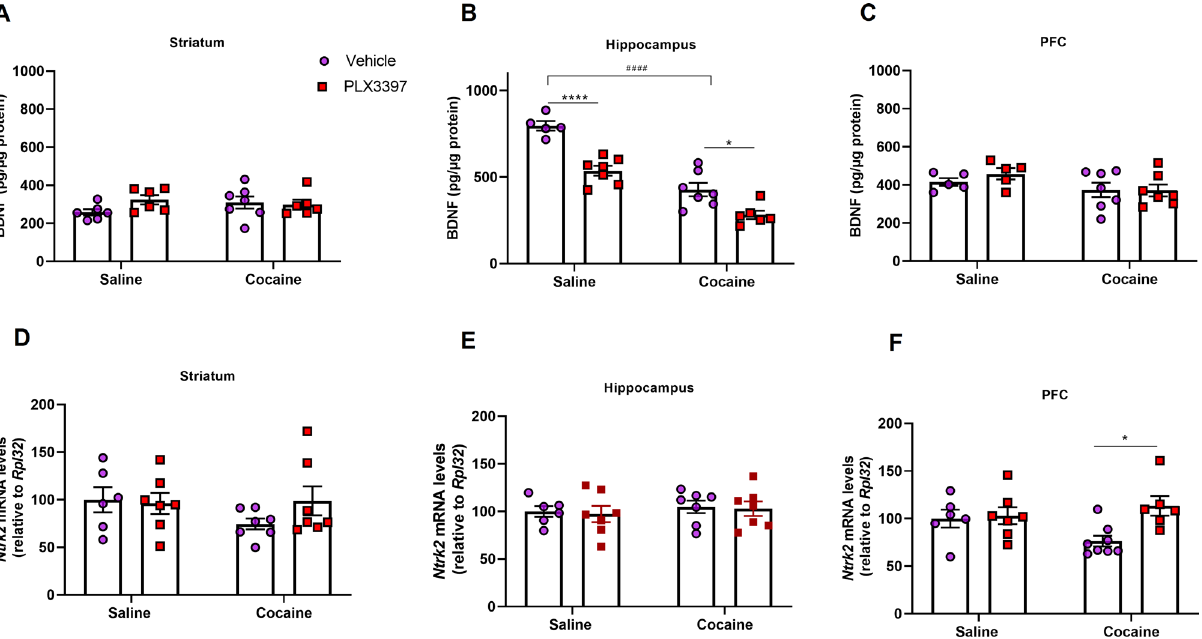
Figure 5. Effect of CSF1R inhibition and cocaine administration on neurotrophic levels and TrkB mRNA expression in the brain. Quantification of BDNF in the striatum [cocaine factor (F (1,21) = 0.27; p = 0.6058), CSF1R inhibition factor (F (1,21) = 1.15; p = 0.2946) and cocaine vs CSF1R inhibition factor (F (1,21) = 2.17; p = 0.1555) ( A ), in the hippocampus [cocaine factor (F (1,21) = 97.38; p < 0.0001), CSF1R inhibition factor (F (1,21) = 41.00; p < 0,0001) and cocaine vs CSF1R inhibition factor (F (1,21) = 3.22; p = 0.0868)] ( B ) and in the PFC [cocaine factor (F (1,20) = 3.81; p = 0.0650), CSF1R inhibition factor (F (1,20) = 0.37; p = 0.5455) and cocaine vs CSF1R inhibition factor (F (1,20) = 0.48; p = 0.4937)] ( C ). Quantification of TrkB mRNA expression in the striatum [cocaine factor (F (1,23) = 0.93; p = 0.34), CSF1R inhibition factor (F (1,23) = 0.75; p = 0.3940) and cocaine vs CSF1R inhibition factor (F (1,23) = 1.41; p = 0.2458)] ( D ), hippocampus [cocaine factor (F (1,23) = 0.51; p = 0.4797), CSF1R inhibition factor (F (1,23) = 0.10; p = 0.7518) and cocaine vs CSF1R inhibition factor (F (1,23) = 0.003; p = 0.9541)]. ( E ) and PFC [cocaine factor (F (1,23) = 0.62; p = 0.4371), CSF1R inhibition factor (F (1,23) = 5.52; p = 0.0265) and cocaine vs CSF1R inhibition factor (F (1,23) = 4.04; p = 0.0563)] ( F ). Results are expressed as mean ± SEM. # p < 0.05, ## p < 0.01 and #### p < 0.0001 difference between the saline and cocaine groups. *p < 0.05 and ****p < 0.0001 compared with the PLX3397 treated group (n = 4–7 in each